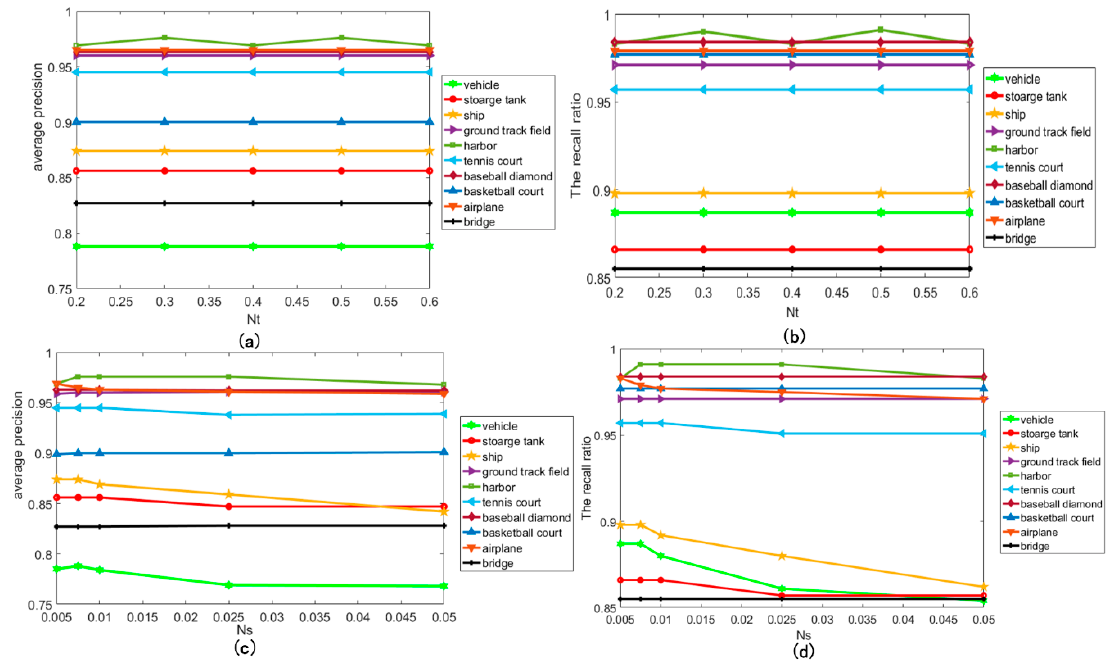
Figure 18. The effect of N s and N t on the recall ratio and AP. ( a ) The effect of N t on the AP. ( b ) The effect of N t on the recall ratio. ( c ) The effect of N s on the AP. ( d ) The effect of N s on the recall ratio.